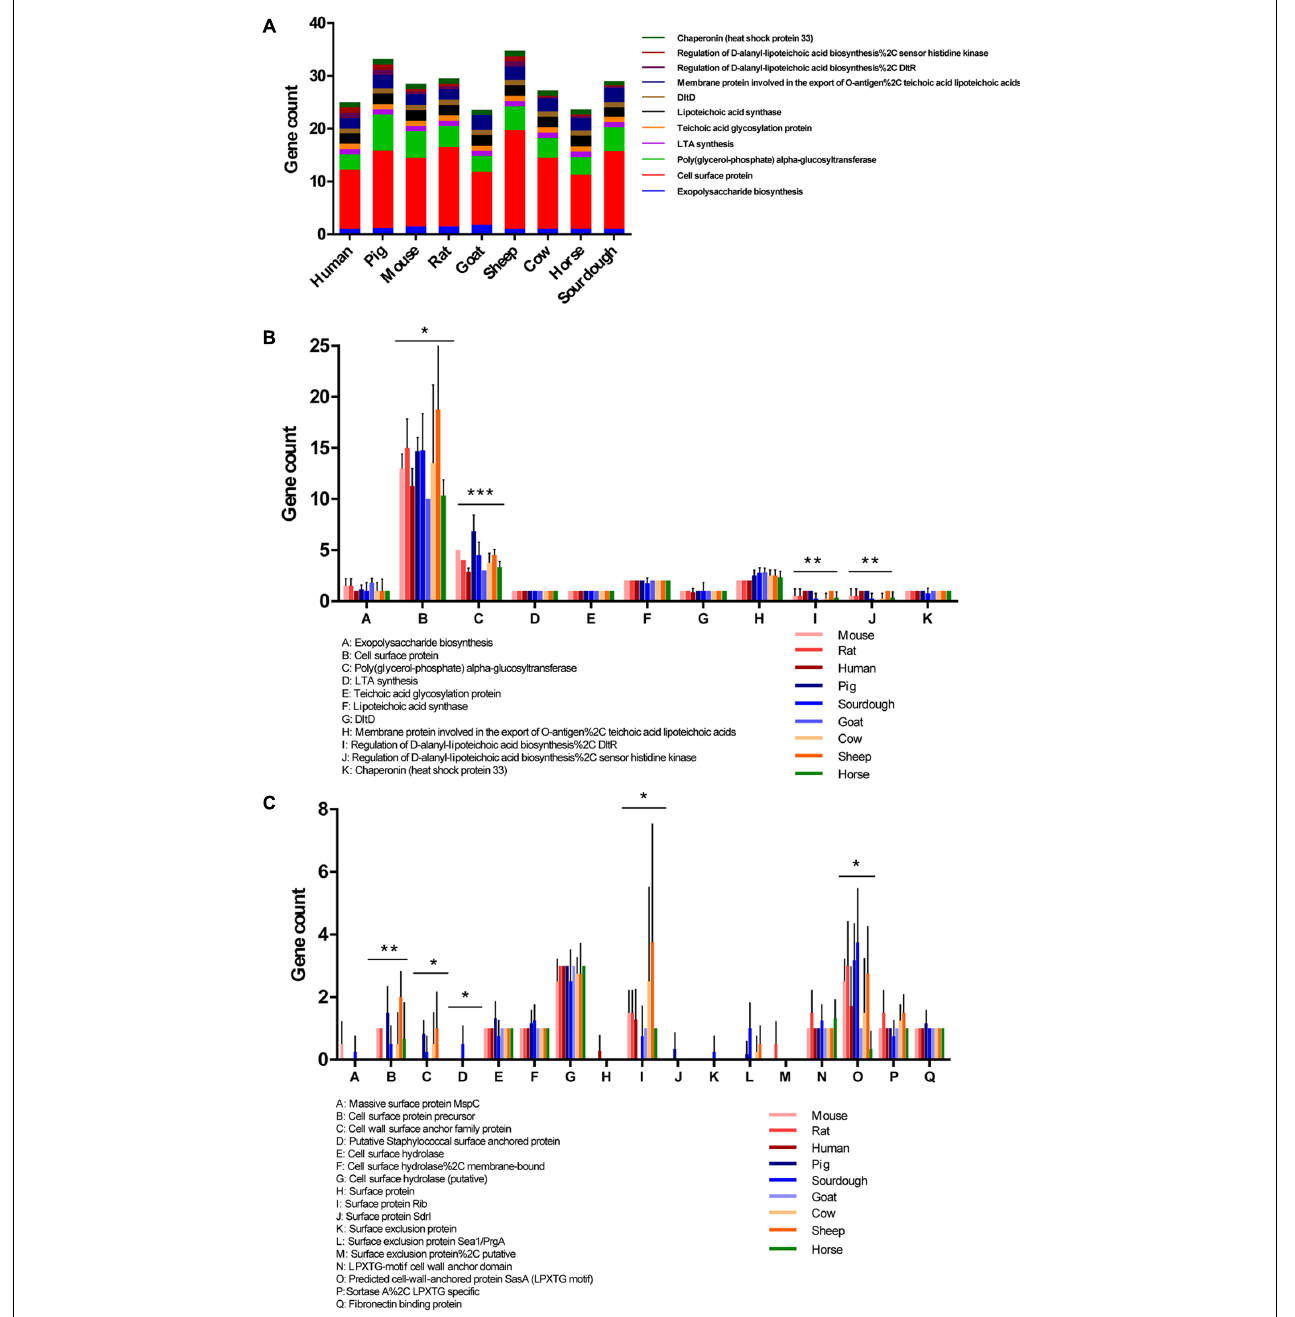
FIGURE 6 | Distribution and abundance of genes related to epithelial adhesion in nine host isolates. (A) Total count of adhesion genes in the nine host isolates. (B) Differential abundance of adhesion genes in strains isolated from nine isolates. (C) Differential abundance of cell surface protein-encoding genes in strains isolated from nine hosts. ∗ p < 0.05, ∗∗ p < 0.01, ∗∗∗ p <